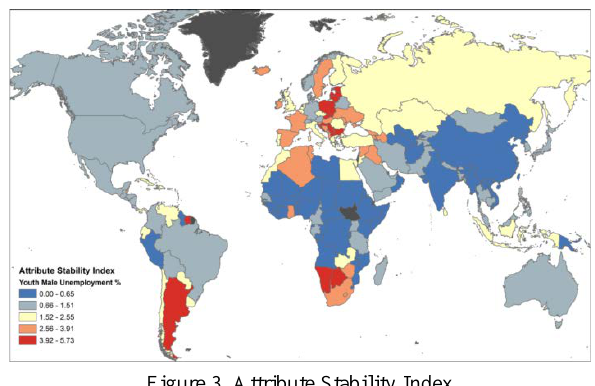
Figure 3. Attribute Stability